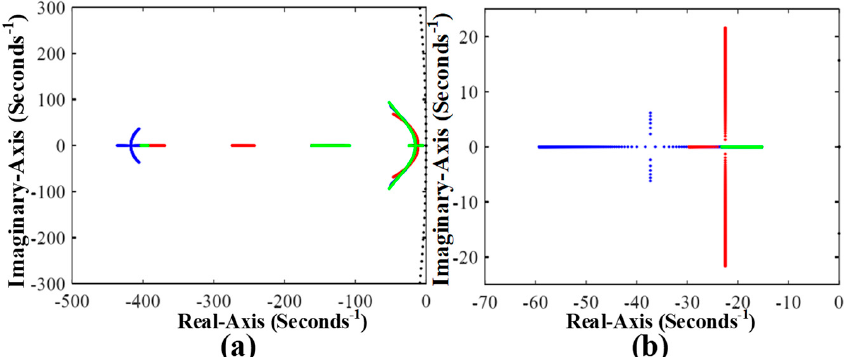
Figure 9. Pole distributions of system between different damping resistance in q -axis: ( a ) pole distribution diagram of motor before design; ( b ) pole distribution diagram of motor after design.